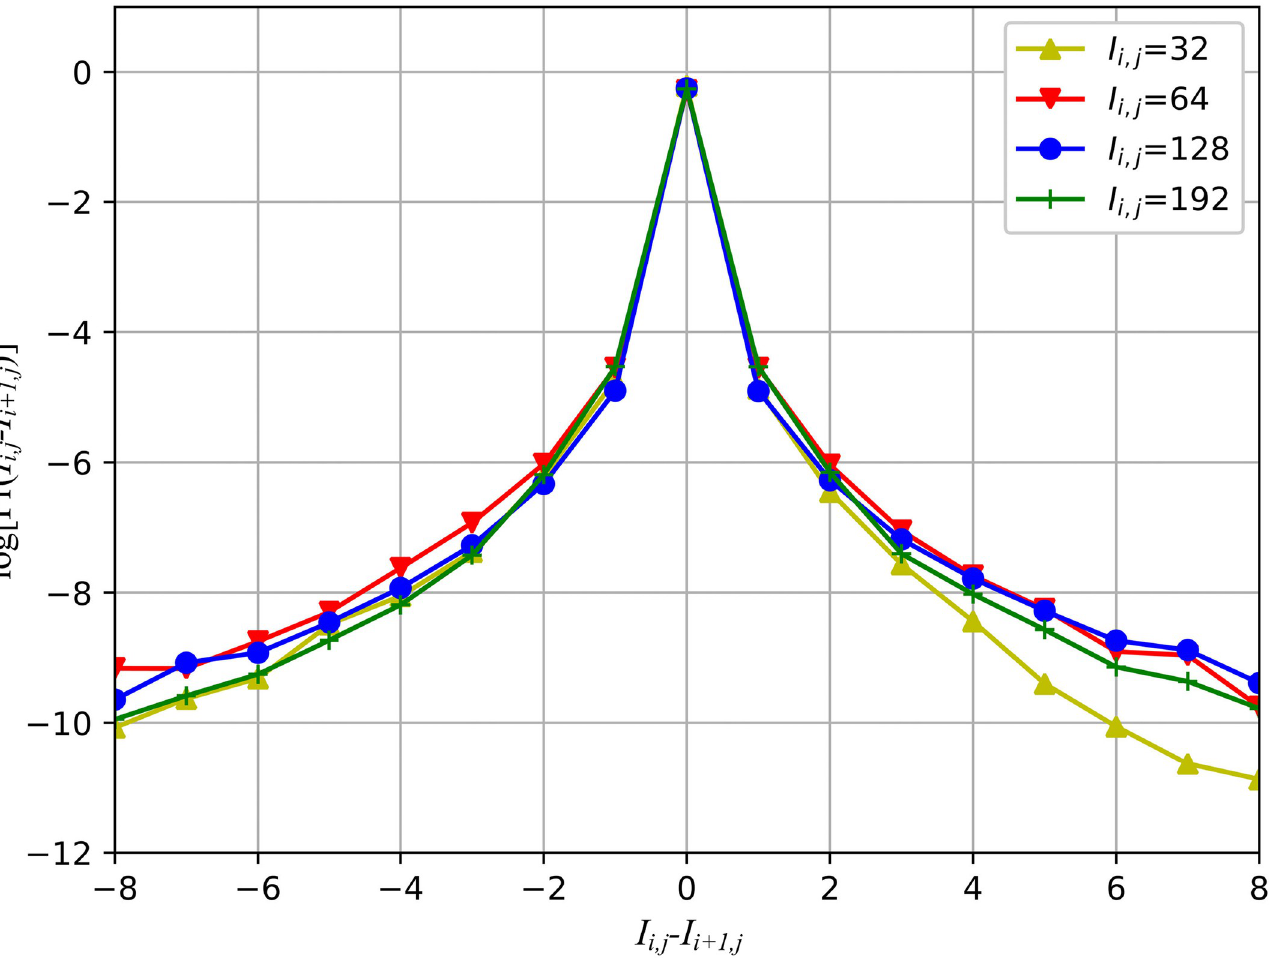
Fig 2. The probability distributions of pixel difference I i , j − I i +1, j . Pr ( I i , j − I i +1, j ) for I i , j 2 {32, 64, 128, 192} estimated from 91 original panoramic images in CVIQA, OIQA and VQA-ODV